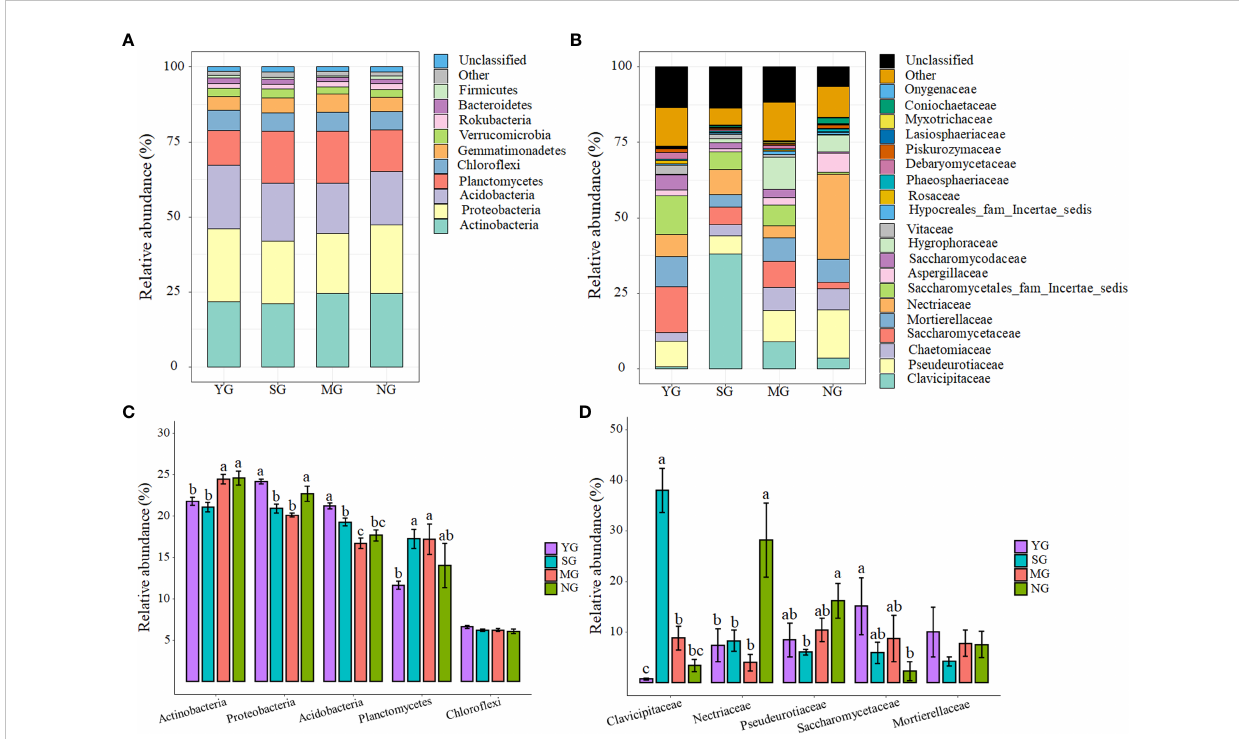
FIGURE 2 Relative abundances of bacterial phyla under different herbivore assemblages (A) ; relative abundances of fungal families under different herbivore assemblages (B) ; dominant bacterial phyla (C) ; dominant fungal families (D) . Signi fi cance level: P < 0.05. YG, Yak grazing; SG, Tibetan Sheep grazing; MG, Yak and Tibetan sheep mixed grazing; NG, No grazing.